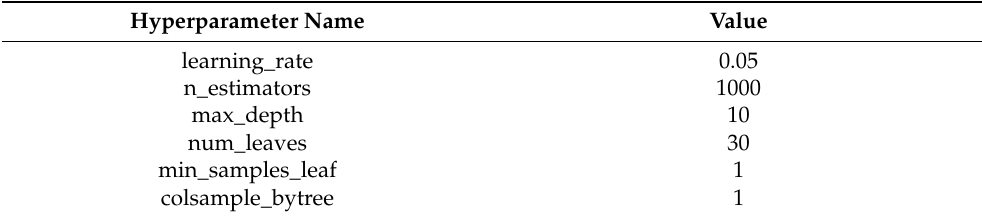
Table 4. Hyperparameter setting of random forest